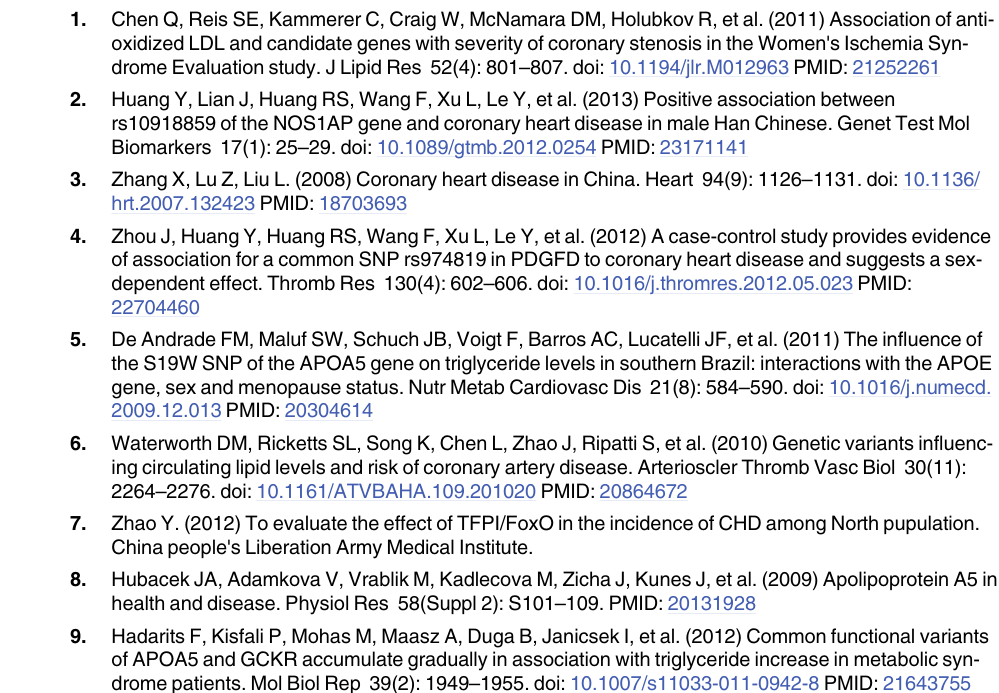
S1 Table. The clinical and demographic details of CHD and non-CHD samples (cid:4) . (cid:4) p values were determined by the Wilcoxon-Mann-Whitney test. S2 Table. Other seven APOA5 polymorphisms involved in the genetic